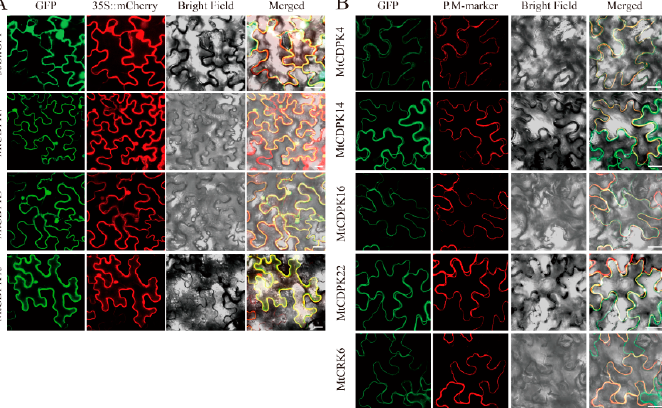
Figure 7. Subcellular localization of MtCDPKs- and MtCRKs-GFP fusion proteins in combination with 35S::mCherry ( A ) and PM-marker ( B ) by using the epidermal cells of N. benthamiana . The tobacco injected with P.M-marker was observed after plasmolysis. PM-marker: plasma membrane localization protein AtAKT1. Bars = 20 μ m.